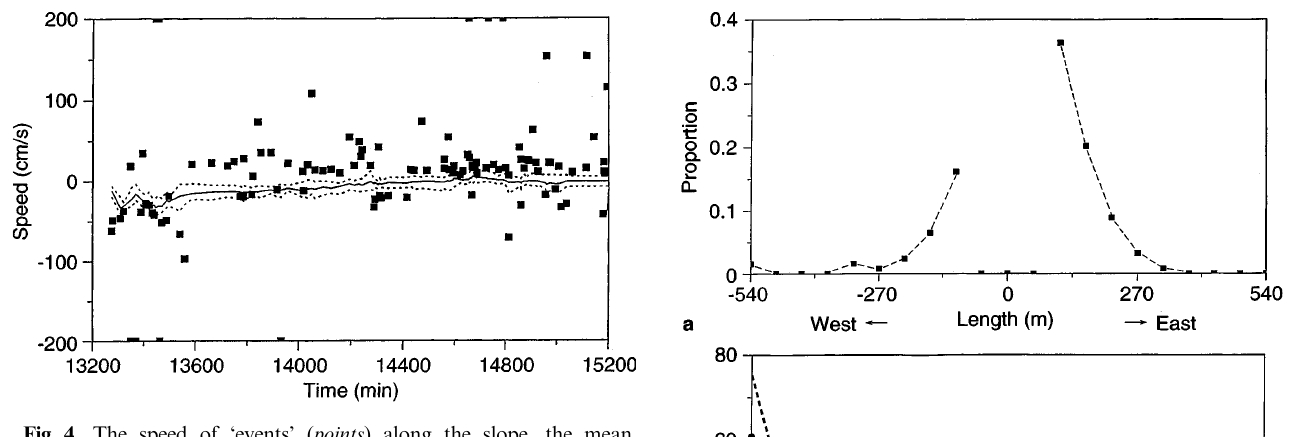
Fig. 4. The speed of ‘events’ ( points ) along the slope, the mean current between 6 and 29 m o(cid:128) the bottom ( solid line ), and the maximum and minimum currents ( dashed ), at times following the surge